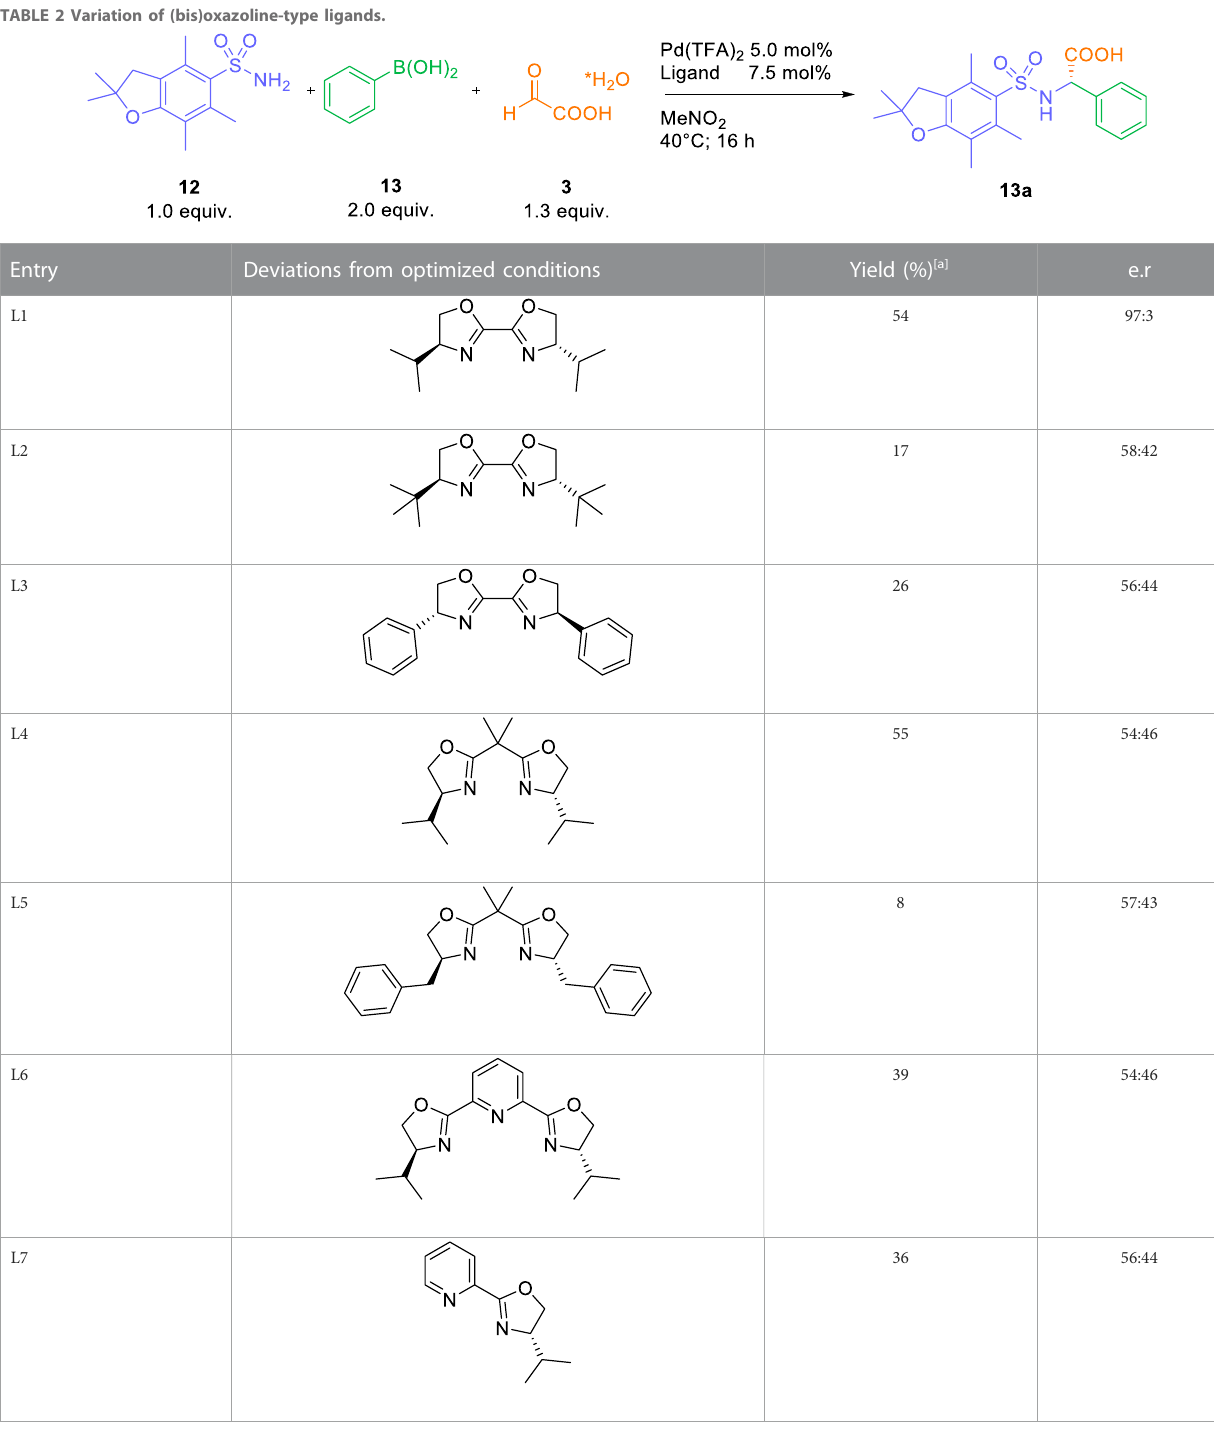
TABLE 2 Variation of (bis)oxazoline-type